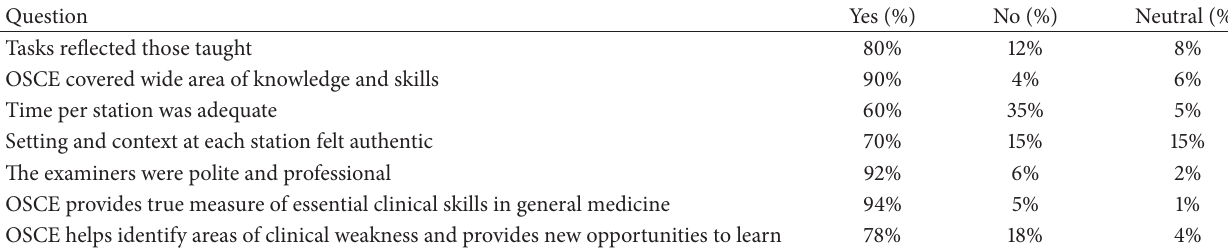
Table 2: Quality of performance testing in